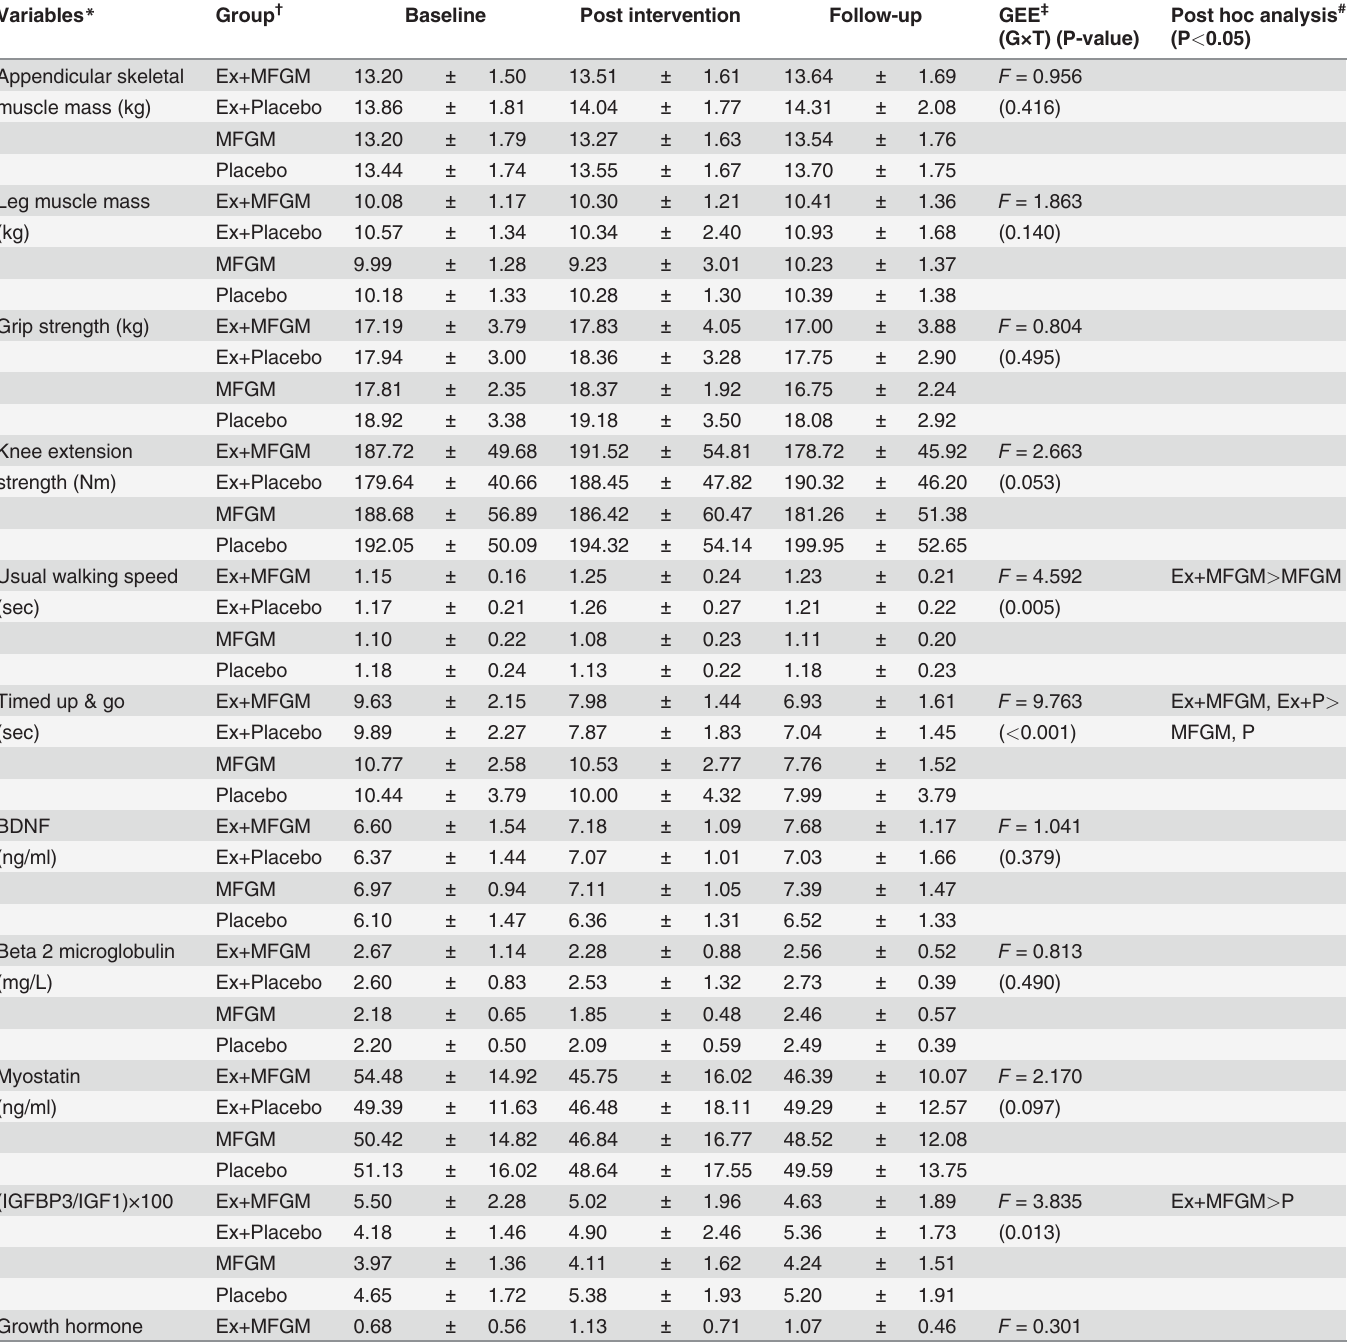
Table 2. Comparison of muscle mass, physical function, and blood component variables among groups after 3-month intervention and follow-